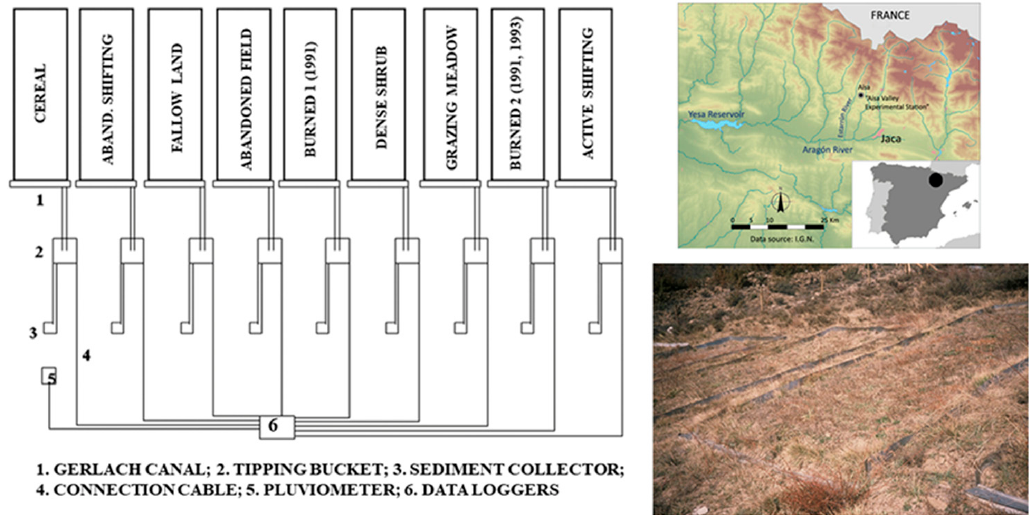
Figure 1. Study area and Aísa Valley Experimental Station scheme and overview of the station.